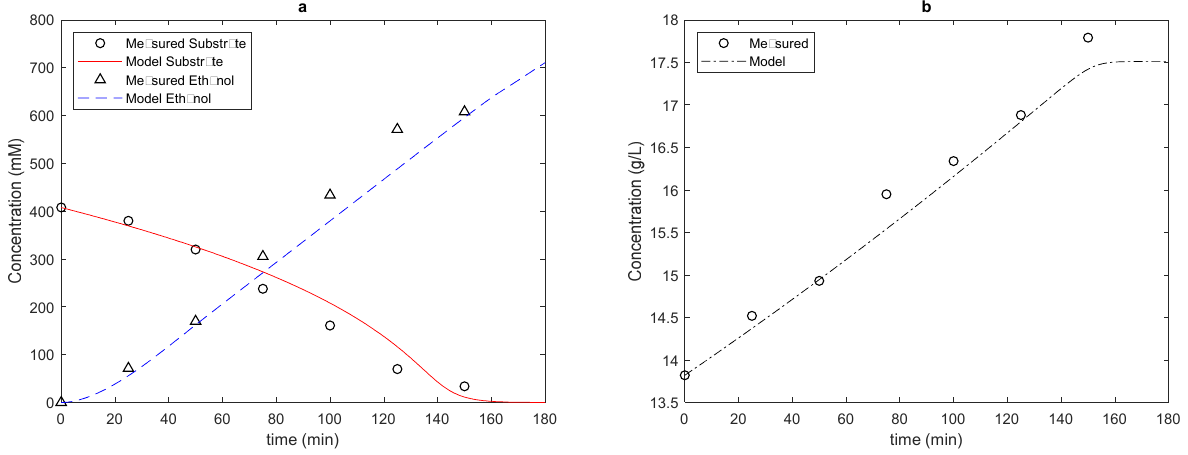
Figure 6. ( a ) Result of the CR model with an initial concentration of 75 g/L, and ( b ) adjustment of cell concentration. Source: prepared by the author.